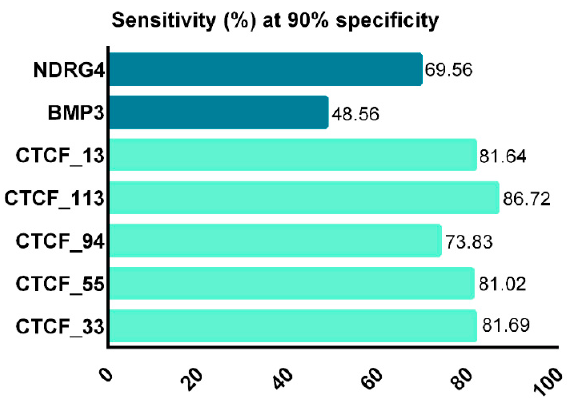
Figure 5. Comparison of CTCF-binding site markers with existing markers (after Liu et al., 2017) [92].